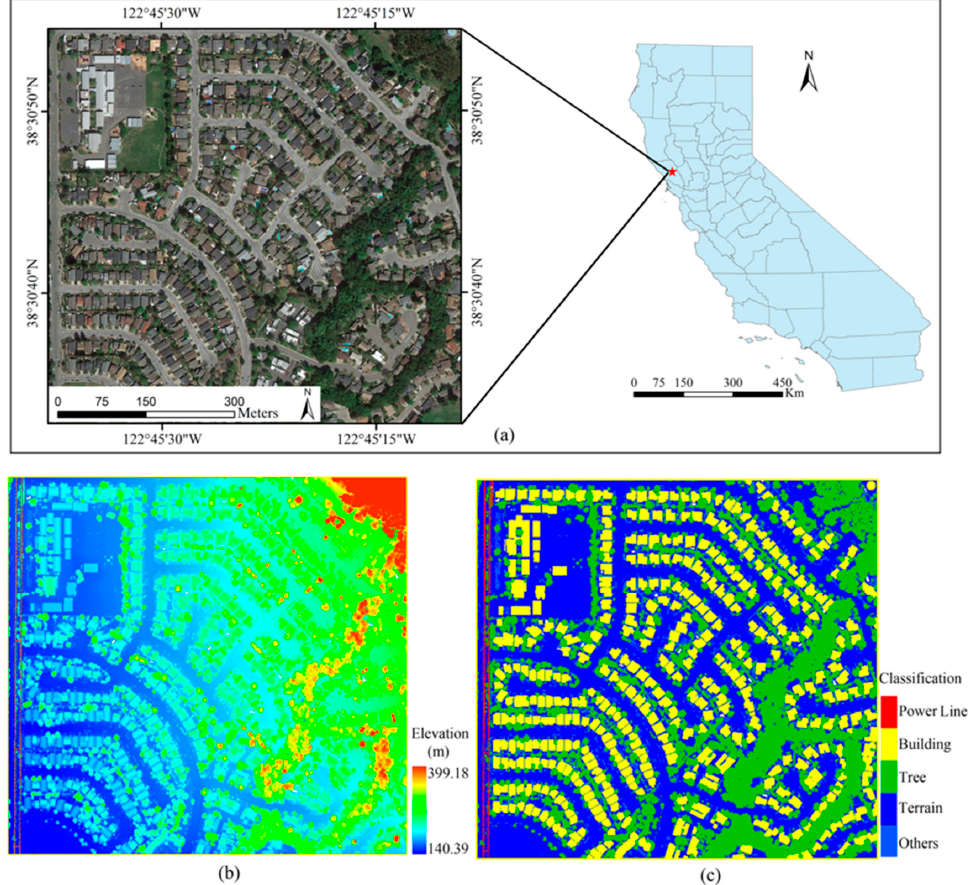
Figure 1. ( a ) The location and overview of the study area; ( b ) light detection and ranging (LiDAR) point cloud colored by point heights; ( c ) ground truth classes interpreted manually.